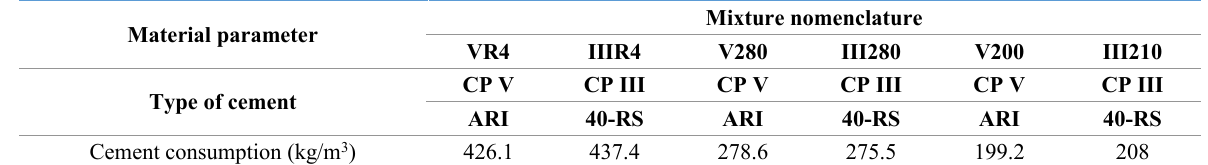
Table 1. Characteristics and nomenclature of the mixtures evaluated. Adapted from Campos et al. [17]. Material